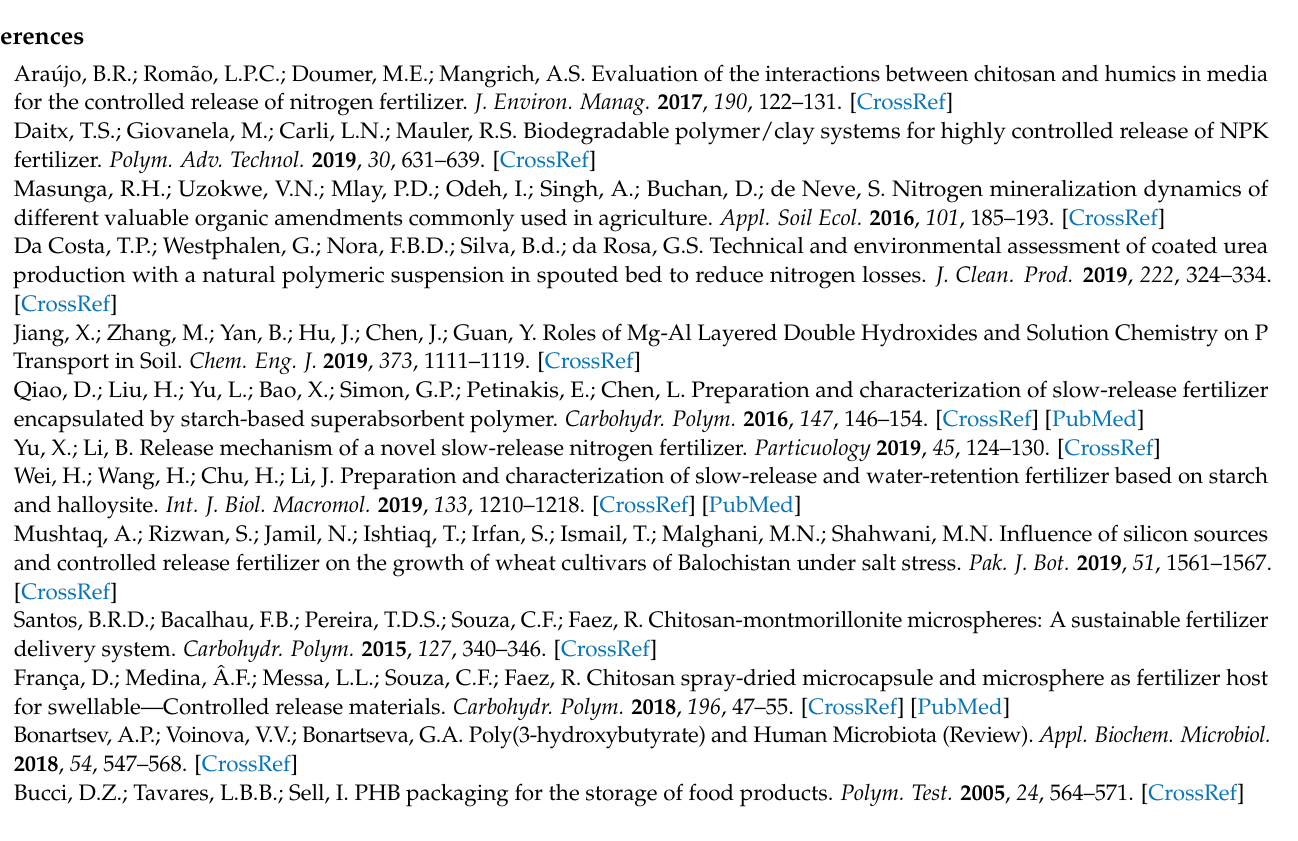
Figure S3: XRD pattern of PHB microcapsules made with 0.5% and